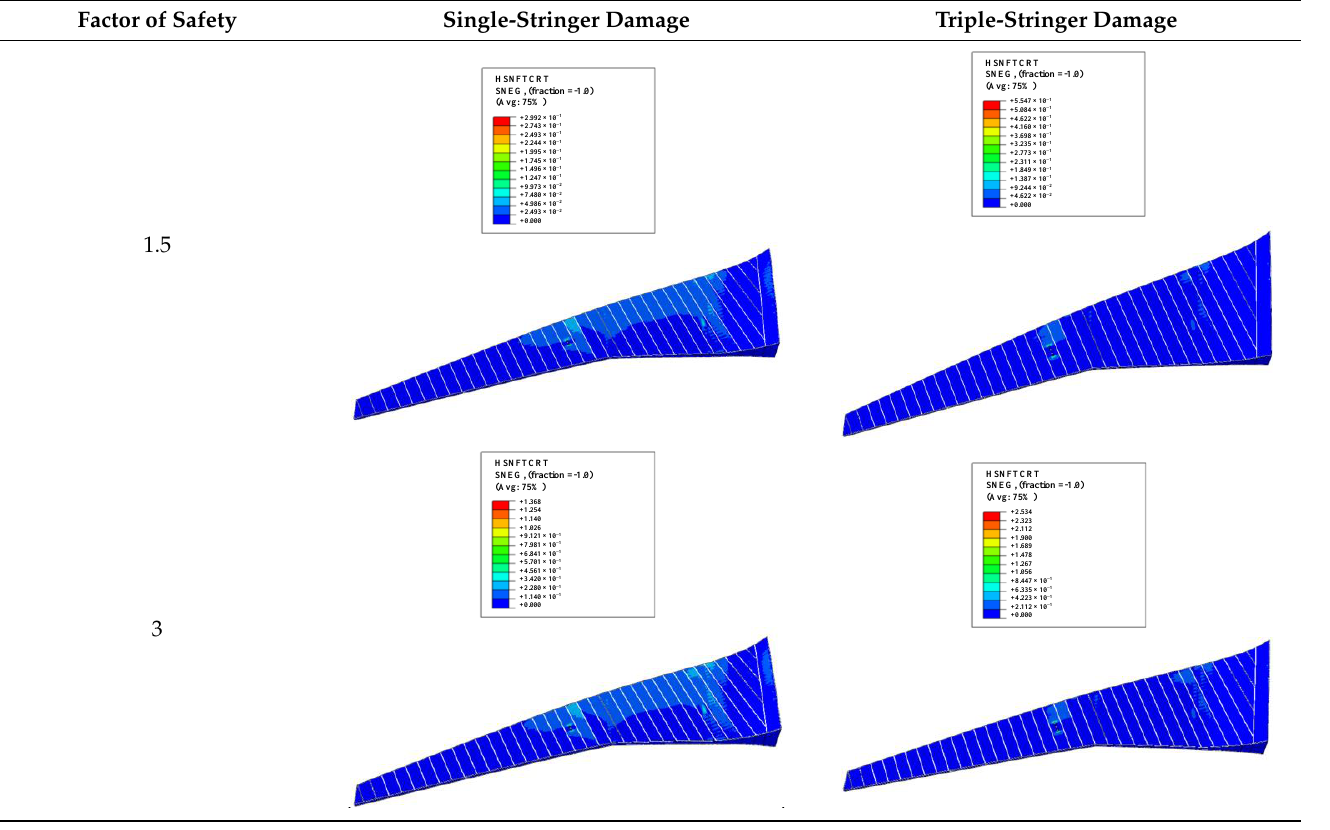
Table 9. Comparison of out-of-plane displacement in the undamaged wing and wing containing stringer